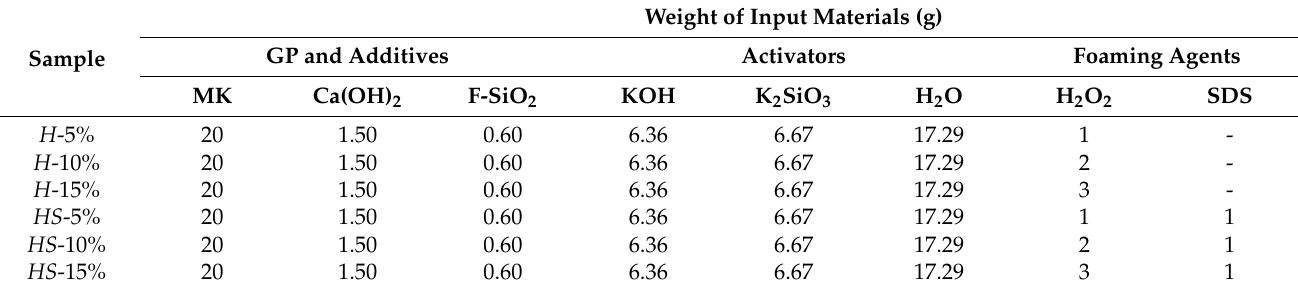
Table 1. Geopolymer formulation and foam agent mass